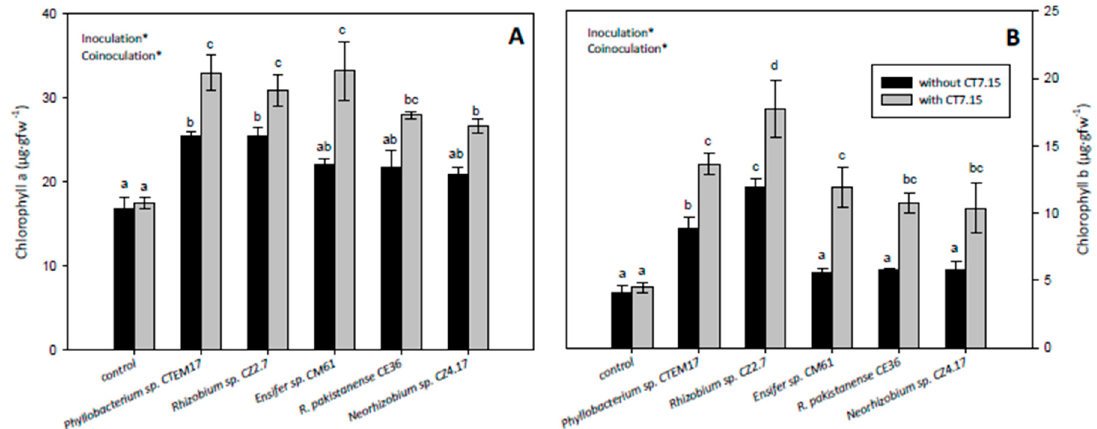
Figure 6. Physiological parameters. Chlorophyll a ( A ) and chlorophyll b ( B ) in randomly selected leaves of Calicotome villosa in response to inoculation with di ff erent rhizobia ( Phyllobacterium sp. CTEM17, Rhizobium sp. CZ2.7, Ensifer sp. CM61, R. pakistanense CE36 and Neorhizobium sp. CZ4.17) in absence and presence of strain CT7.15 as co-inoculant for 5 months. Values represent mean ± SE, n = 6. Di ff erent letters indicate means that are significantly di ff erent from each other (GLM, inoculation × co-inoculation; LSD test, p < 0.05). Inoculation, co-inoculation or inoculation × co-inoculation in the corner of the panels indicate main or interaction significant e ff ects ( ∗ p < 0.001).